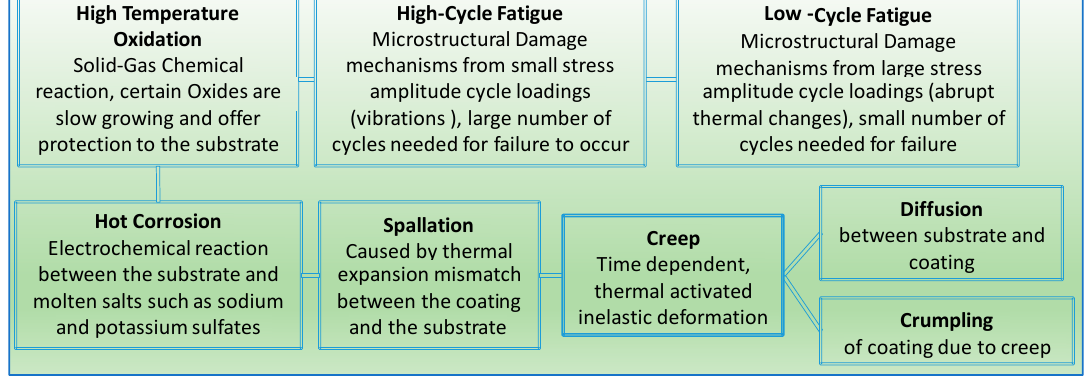
Figure 5. Chart of common failure mechanisms of TBCs and EBCs .